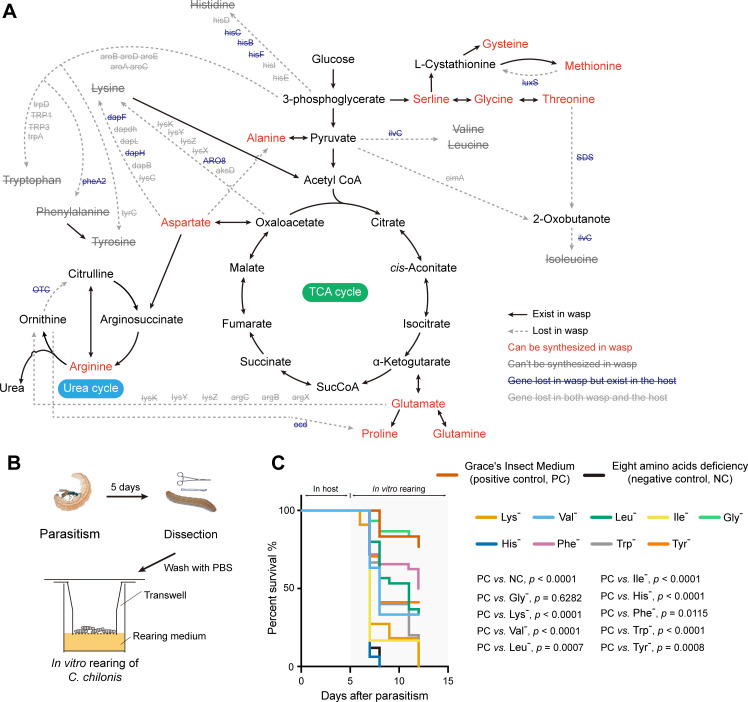
C. chilonis loses the ability to synthesize eight amino acids.(A) Gene loss in amino acid biosynthetic pathways in C. chilonis. BlastKOALA web server and iPathCons tool were used for re-constructing the amino acid biosynthetic pathway in C. chilonis with annotated C. chilonis protein coding genes. For those genes missing in the first step, we searched them in whole genome assembly and PacBio long reads by TBLASTN (see Materials and methods). In total, 46 genes were found to be missing in the amino acid biosynthesis pathway for C. chilonis, thus disrupting the biosynthesis of eight amino acids (Lys, Trp, Phe, Tyr, Ile, Leu, Val, His). Full line indicates the reaction exists in C. chilonis, while dotted line indicates the interaction cannot be found. Amino acid names in red can be synthesized by C. chilonis, names in gray with strikethrough cannot be synthesized due to the lost genes on each dotted line. (B) In vitro rearing of C. chilonis. Five days after parasitism, larvae were put on the membrane of a transwell chamber; then the transwell was placed in the well containing 250 μl of Cotesia rearing medium so that the wasp larvae could reach the nutrients (see Materials and methods). (C) Survival rates of C. chilonis larvae developed on 11 different rearing media, respectively. Positive control: Grace's Insect Medium, containing 20 amino acids (see Materials and methods, n = 30); Negative control uses positive control medium minus the eight amino acids that C. chilonis cannot synthesize, Lys, Trp, Phe, Tyr, Ile, Leu, Val, His, n = 30; Single amino acid deficiencies use control media minus only one amino acid, indicated by '-' superscript, for example Gly deficiency (Gly-) indicates excluding glycine only. Gehan-Breslow-Wilcoxon test was used for survival rate statistical analyses. The Benjamini-Hochberg method was used for multiple testing correction. The statistical results of pairwise group comparisons are indicated.Figure 4—source data 1.Genes in amino acid biosynthetic pathways of C. chilonis.Figure 4—source data 2.This table includes the survival rates of C. chilonis larvae developed on 11 different rearing media.